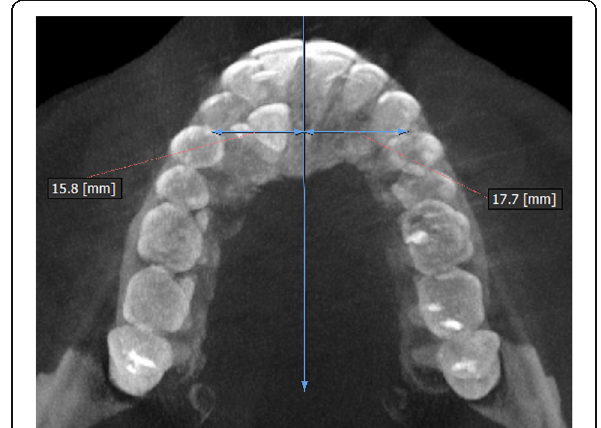
Fig. 7 Premolar width. Distance in millimeters from the middle palatine raphe till proximal alveolar bone crest between the canine and first premolar on each side; measured in the axial cut at bone crest